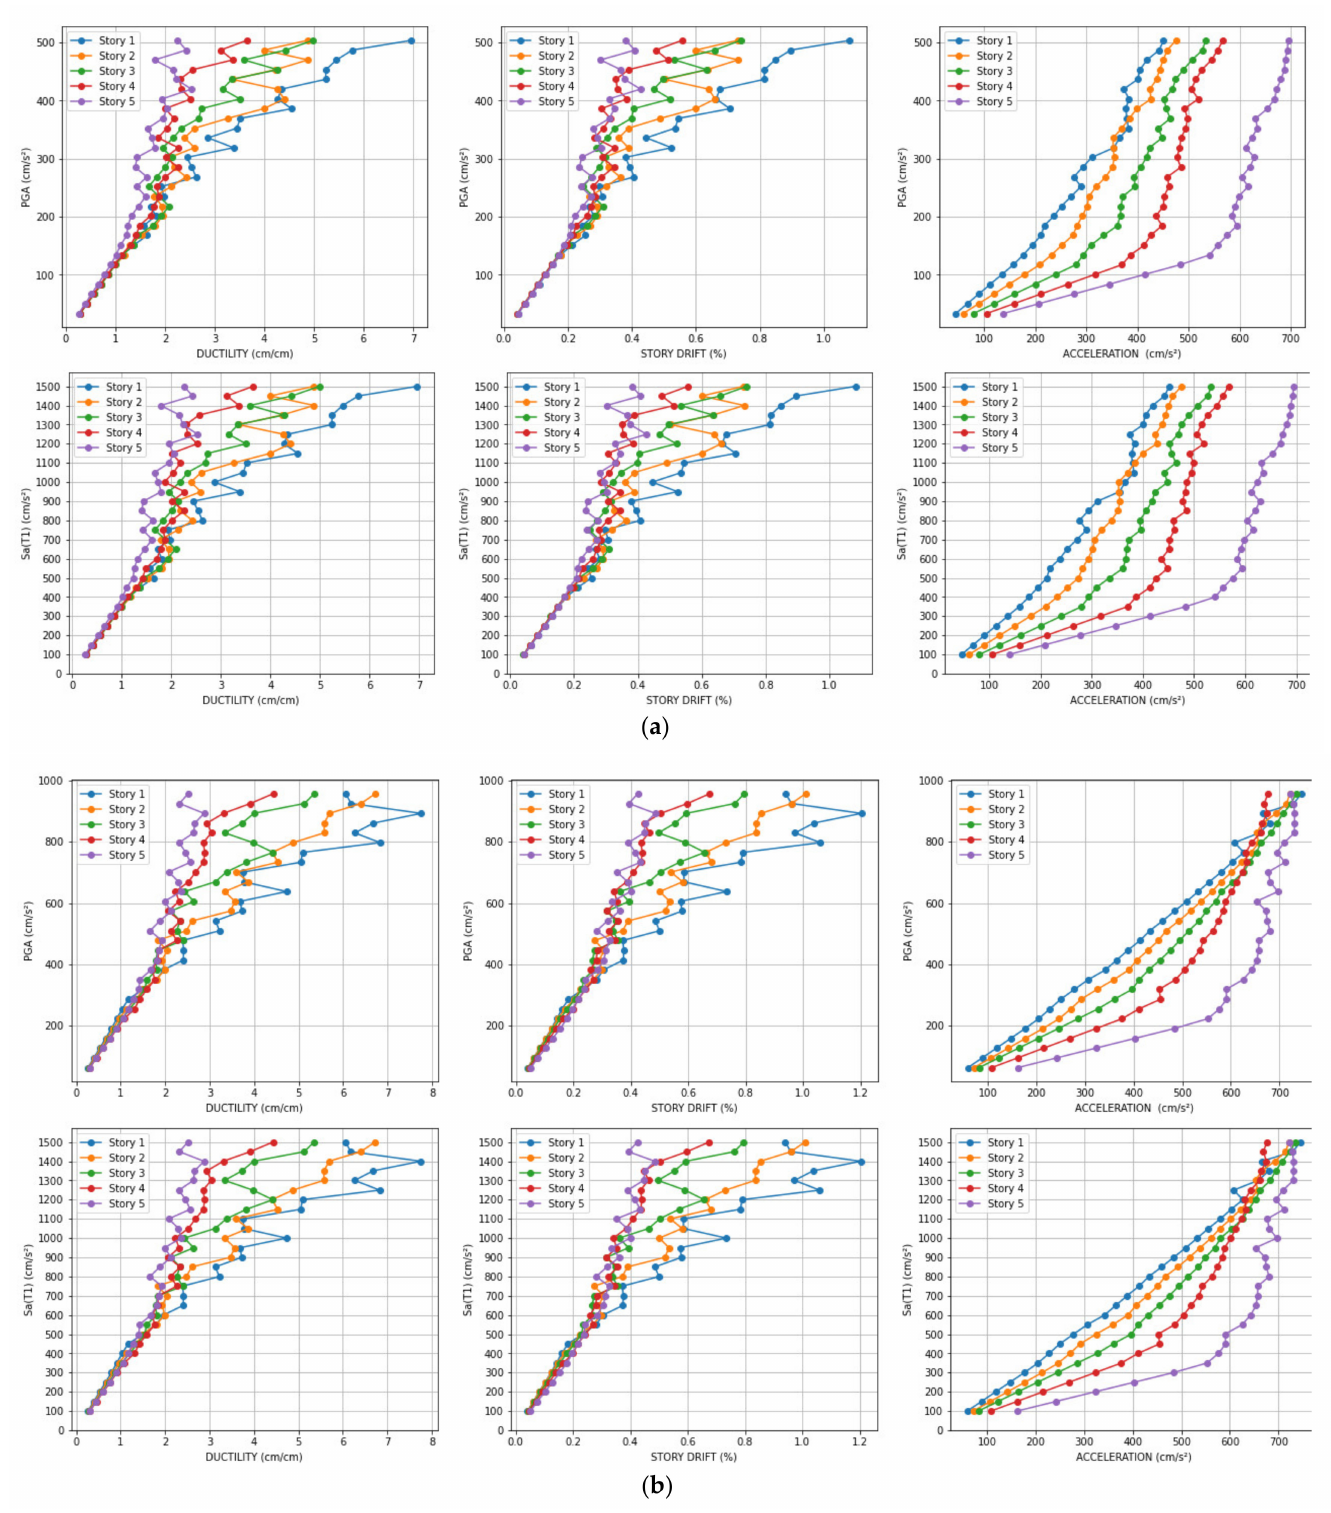
Figure 18. ( a ) Incremental structural responses for damage identification in each story with “El Centro 1940” input ground motion; ( b ) Incremental structural responses for damage identification in each story with “Northridge” input ground